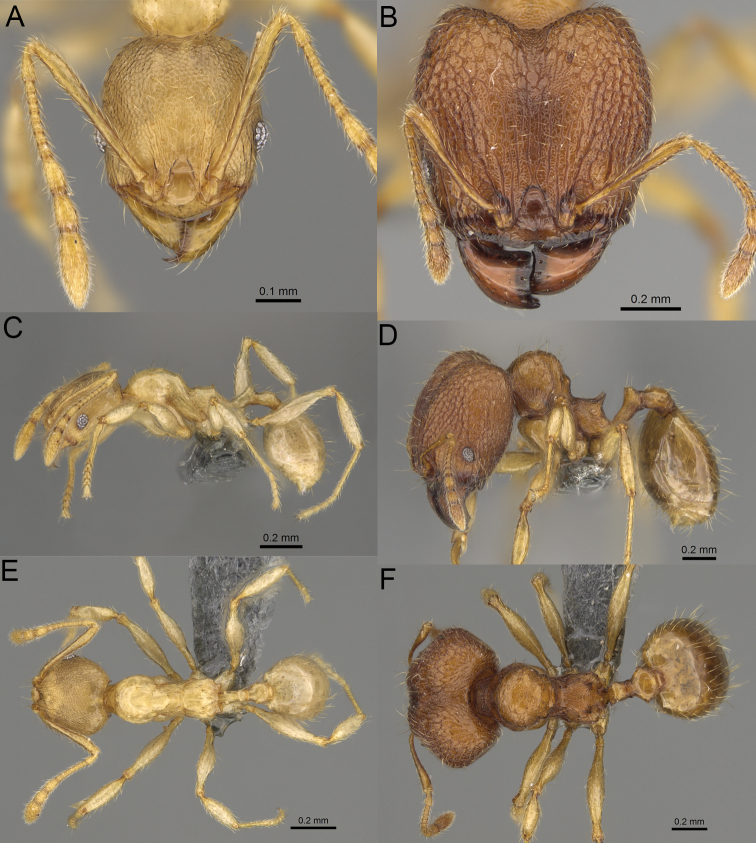
Pheidole
havoana sp. nov., full-face view (A), profile (C), and dorsal view (E) of paratype minor worker (CASENT0923290) and full-face view (B), profile (D), and dorsal view (F) of holotype major worker (CASENT0704280).